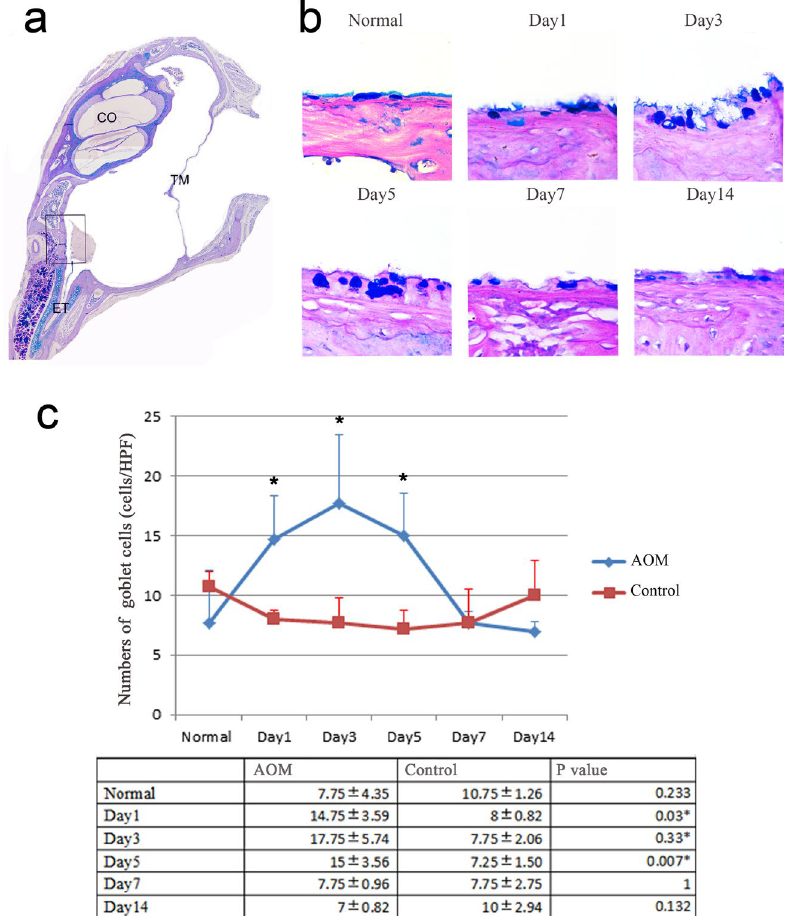
Figure 3. Induction of mucous cell metaplasia (MCM) in the middle ear of mouse AOM. Sections were stained with AB-PAS for evaluation of macroglycoconjugate expression. Goblet cells stained blue or purple in colour by AB-PAS were counted under a light microscope. The same location shown in the box in Fig. 3A in each slide was chosen. The number of goblet cells was counted and expressed as cell number per high-power field. (n = 6). ( a ) The location of observation. TM: tympanic membrane, ET: Eustachian tube, CO: cochlea. (scale bar, 500 µ m). ( b ) Increasing AB-PAS positive cells in AOM mucosa compared with control middle ear mucosa. (scale bar, 20 µ m). ( c ) The average number of goblet cells per high-power field in each group at different times after Streptococcus pneumoniae injection. Error bars show S.D. Data are presented as mean + S.D. (n = 6 per group). * p <